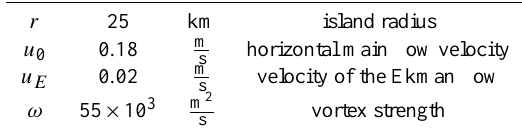
Table 1. Some of the hydrodynamic parameters used in the hydro- dynamic model. For a detailed description of the parameterization cf. Sandulescu et al.